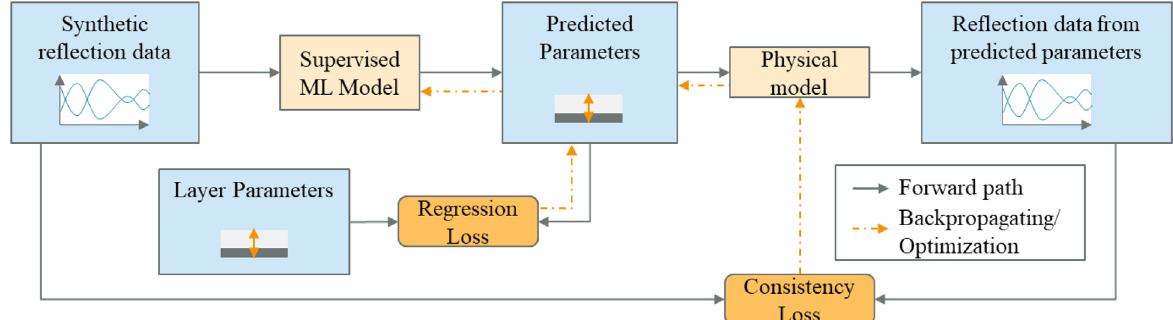
Fig. 3. Scheme of the hybrid model architecture. The physical model together with the consistency loss is added to the classic optimization procedure. By erasing the regression loss, the same scheme also describes the re fl